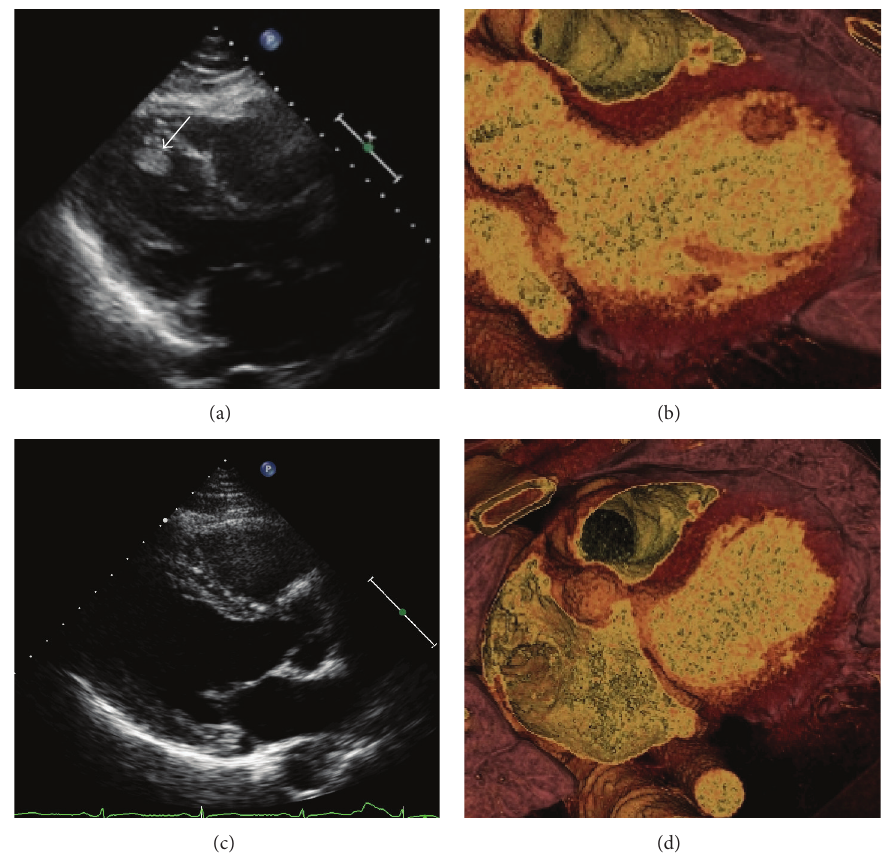
Figure 2: Imaging findings of a ball mass in the left ventricle (LV) on admission. This imaging revealed a ball mass (arrow) in the left ventricle (LV) detected by transthoracic echocardiography (TTE) (a) and contrast enhanced computed tomography (CT) (b). We confirmed that it had disappeared after anticoagulant therapy including rivaroxaban on the 14th day from TTE imaging (c) as well as CT imaging (d). Therefore, we diagnosed this ball mass as a